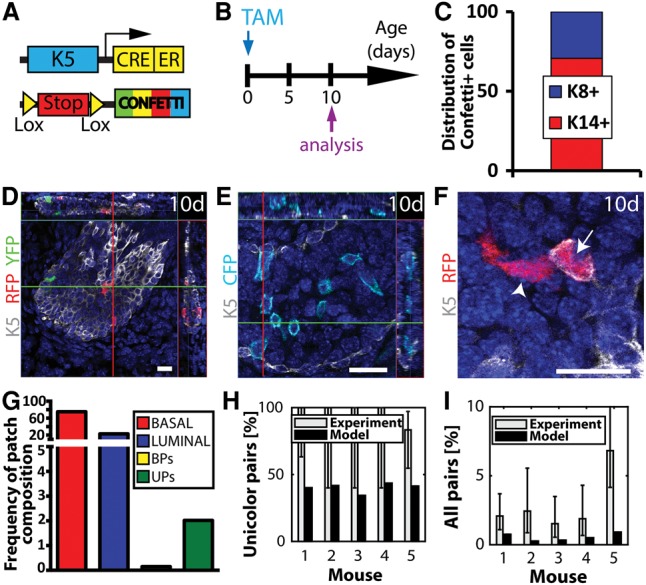
K5CreERT2 targets multipotent BCs that give rise to LCs in the prostate. (A) Scheme summarizing the genetic strategy used to induce Confetti expression in K5-expressing cells during prostate postnatal development. (B) Scheme summarizing the protocol used to study the fate of cells targeted during postnatal development using K5CreERT2/Rosa-Confetti mice. (C) Distribution of basal K14+ and luminal K8+ cells among Confetti+ cells 10 d after TAM (0.1 mg) administration at birth to K5CreERT2/Rosa-Confetti mice (1268 cells out of five mice). (D–F) Confocal imaging of immunostaining of K5 and fluorescent Confetti cells 10 d after TAM (0.1 mg) administration at birth to K5CreERT2/Rosa-Confetti mice. Isolated BCs (D) and LCs (E) as well as UPs containing BCs and LCs (F) were observed. In D, the section depicted represents the surface of the duct, meaning that the cells expressing K5 are located at the surface of the duct and not inside. This is illustrated by the red and green lines in the orthogonal sections of the WM. (G) Frequency of Confetti+ patch compositions 10 d after TAM (0.1 mg) injection at birth to K5CreERT2/Rosa-Confetti mice. (H) Fraction of UPs among all pairs 10 d after TAM (0.1 mg) administration at birth to K5CreERT2/Rosa-Confetti mice. Experimental bars (gray) represent the number of UPs divided by the total number of pairs. Model bars (black) represent the prediction of the fraction of UPs among all pairs, which depends only on the relative frequencies of the Confetti colors. (I) Fraction of total pairs 10 d after TAM (0.1 mg) administration at birth to K5CreERT2/Rosa-Confetti mice. Experimental bars (gray) represent the total number of pairs divided by the total number of induced BCs (approximated by the number of cohesive groups of BCs). Model bars (black) represent the prediction of the overall frequencies of pairs, which is based on the probability of random labeling of BCs, taking into account the architecture of the tissue (i.e., how many LCs touch a BC), the degree of chimerism, the CRE specificity, and the frequency of recombination of each Confetti color. (D,E) Orthogonal projections of 3D stacks. (F) Single-plane image from a 3D stack. Bars, 20 µm. Histograms represent the mean. Error bars represent standard deviation. See Supplemental Table S4 for further information on the statistics.